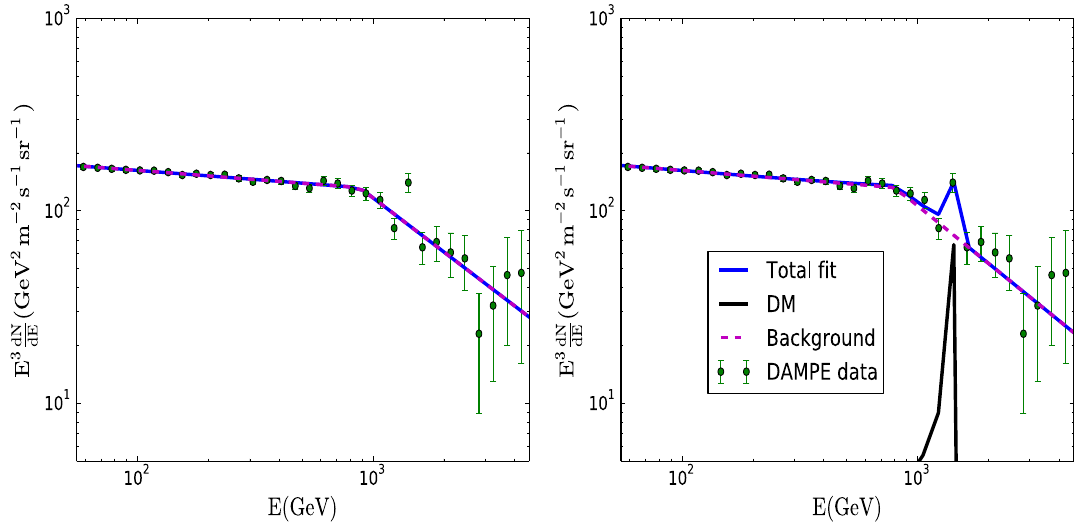
Fig. 2 Best-fit of the e + e − spectrum generated by the process χχ → Z (cid:3) Z (cid:3) with Z (cid:3) → e + e − ,μ + μ − to the DAMPE data with the back- ground parameterization taken from [16]. The left panel is based on